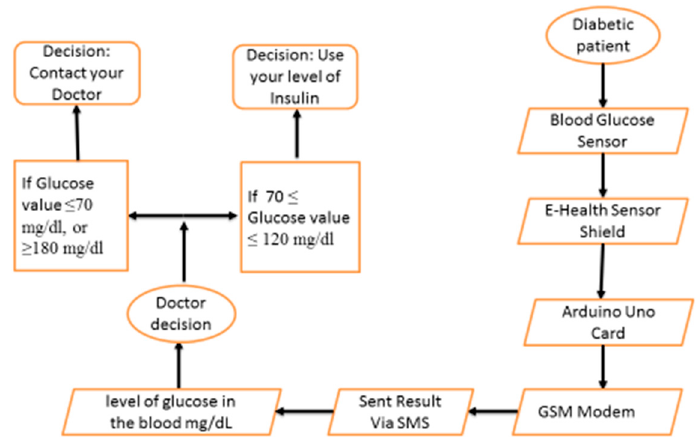
Figure 5. Flow chart of the system.